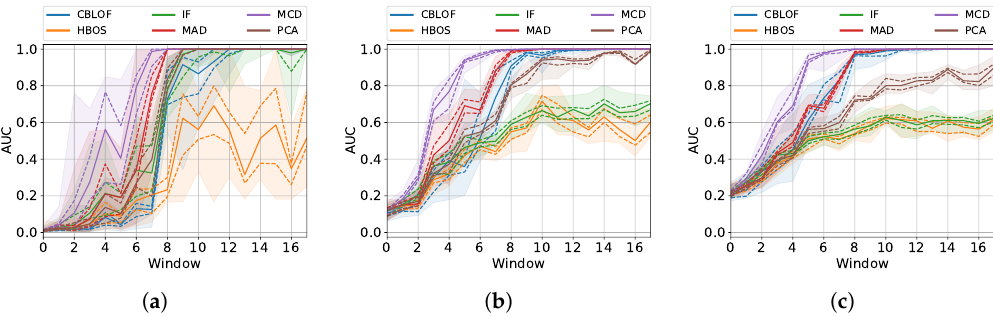
Figure 11. Drift fault: evolution of the area under the curve (AUC) score along the windows. The performances are strongly sensitive to the outliers contamination. The shade extends from the minimum and maximum values of the data, the dashed lines represents the first and third quartiles, while the solid line is the median (second quartile). ( a ) 1% of contamination. ( b ) 10% of contamination. ( c ) 20% of contamination.